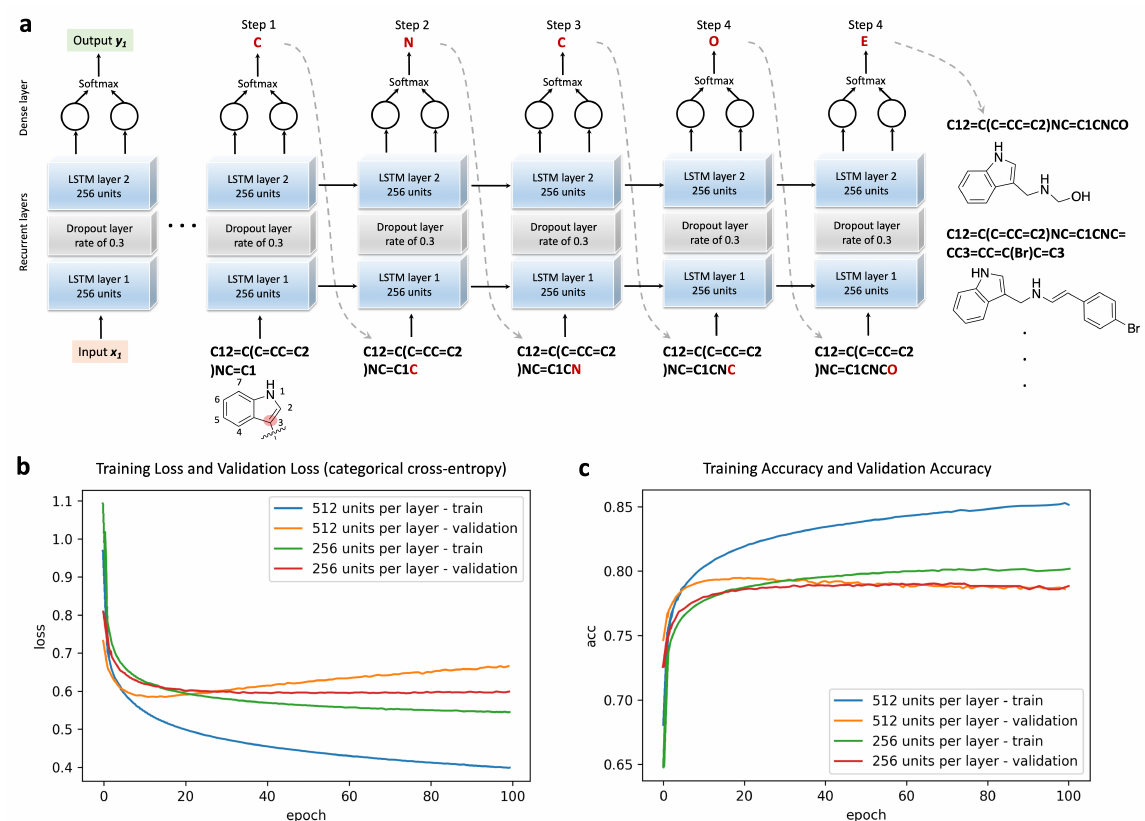
Figure 2. The training and sampling of the recurrent neural networks (RNN) model with long-short- term memory (LSTM) units. ( a ) The architecture of the neural network and the example sampling process with the indole ring as the input. ( b ) Training loss and validation loss at different training epochs. ( c ) Training accuracy and validation accuracy at different